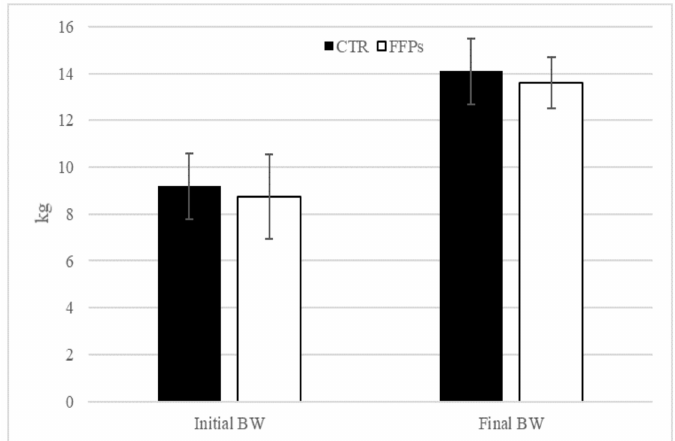
Figure 1. E ff ects of partial replacement of conventional cereals by FFPs on initial and final body weight. CTR = standard diet; FFPs = former foodstu ff s products diet; BW = body weight; FCR = feed conversion ratio; Value for each item is the mean ± SEM (standard error of the mean).